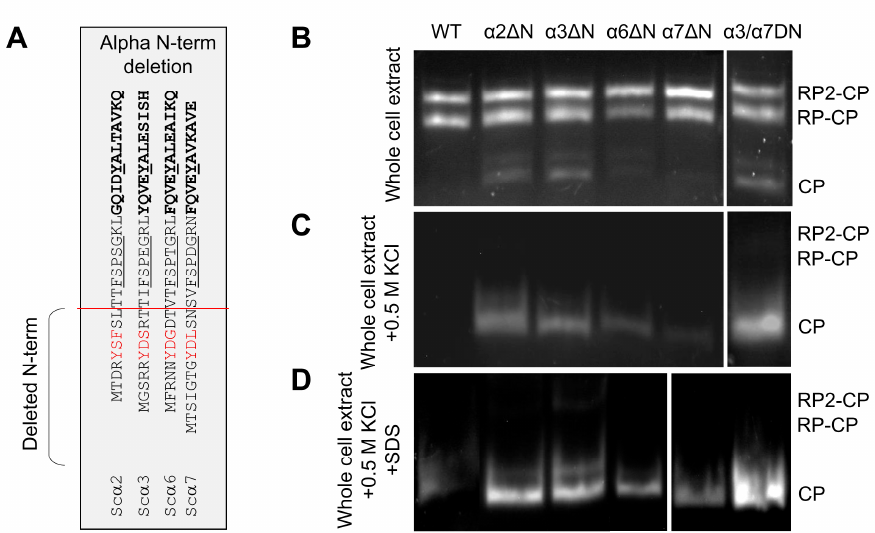
Figure 2. Effect of α -subunit N-terminal truncation on proteasome peptidase activity. ( A ) In the table, the red line shows the position of the amino acid sequences deleted from the N-termini of the α subunits to make the corresponding Δ N-mutant strains. ( B–D ) Non-denaturing gel electrophoresis of natively lysed whole cell extract followed by in-gel peptidase activity assay to visualize 26S holoenzymes and 20S CPs. Symmetric (RP 2 CP) and asymmetric (RP 1 CP) forms of the holoenzyme as well as the CP form, are indicated from the crude extract of WT and Δ N mutants ( B ) after adding 0.5 M KCl and incubation of the cell extracts in 30 °C for 30 min ( C ), and at the above condition in C supplemented with 0.02% SDS ( D ).